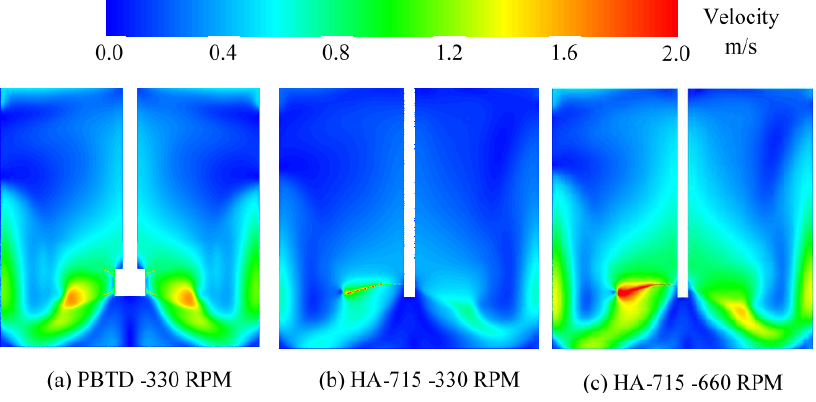
Figure 4. Flow field contours in a stirred tank generated by PBTD and